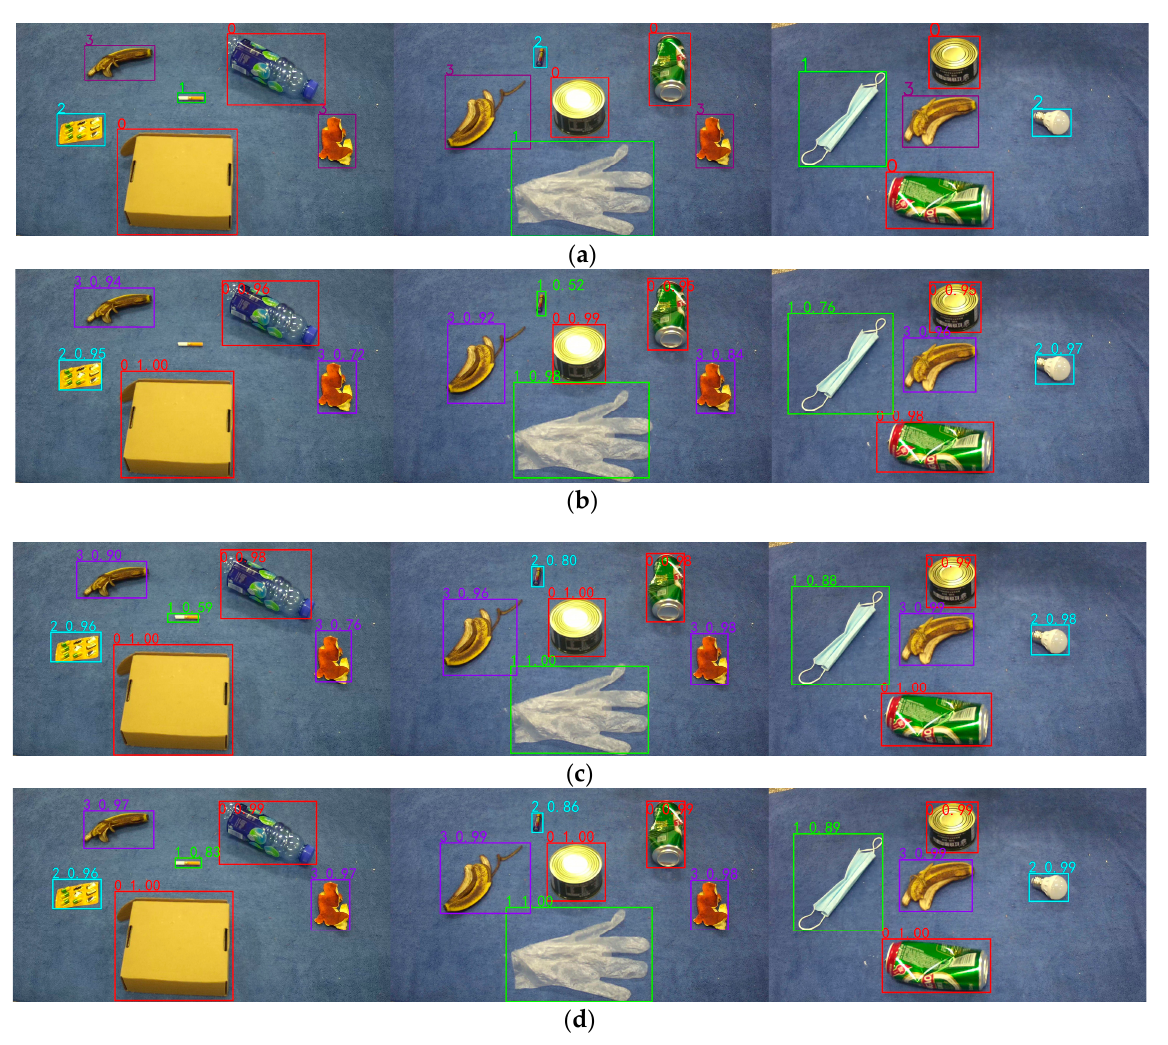
Figure 11. Comparison of model detection e ff ects of di ff erent improved methods: ( a ) real label; ( b ) YOLOv4; ( c ) YOLO_EC; and ( d ) data augmentation + YOLO_EC.